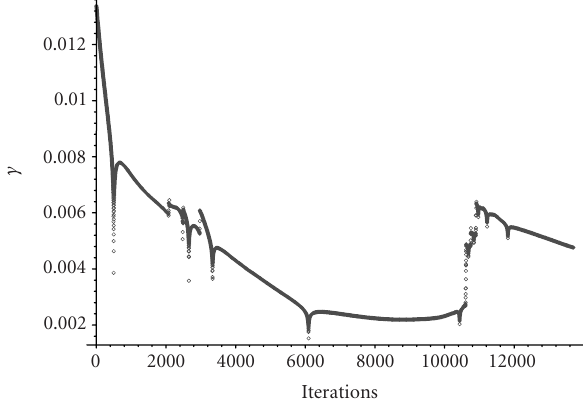
Figure 5.8. The largest averaged Lyapunov exponent (the values must be divided by the size of the interval 10 − 7 ) as a function of the accumulated τ . We have used interval 0 . 4 × 10 − 6 . Note the sharp jump at approximately 10,400 steps, indicating the development of a very large instability in this neighborhood (the additional terms here are divided by 10 4 , the number of time